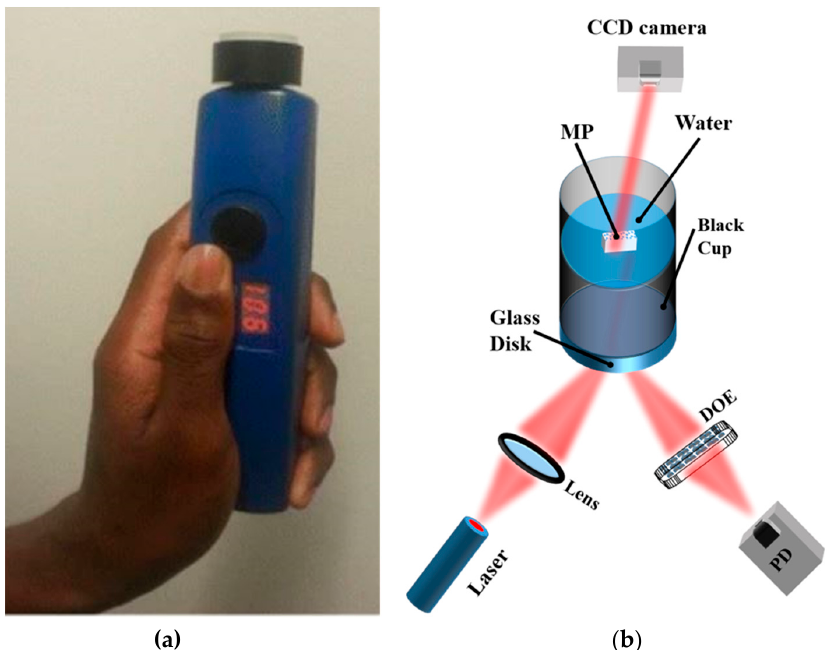
Figure 8. ( a ) Image of a handheld optical sensor for MP detection [117]; ( b ) optical measurement setup. The diffractive optical element (DOE) spatially filters the reflected light signal to obtain the specular component of the light signal on the photodiode (PD). The speckle pattern is measured by the CCD camera [23]. Reprinted from Chemosphere , 254, Asamoah, B.O.; Roussey, M.; Peiponen, K. On Optical Sensing of Surface Roughness of Flat and Curved Microplastics in Water, 126789. [23], Copyright (2020), with permission from